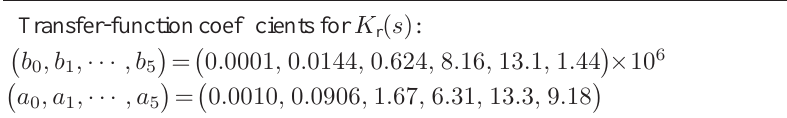
Table 1. Parameter values for the Wavestar C5 absorber. Parameter Symbol Value Unit Inertia of arm and float (with ballast water) J mech Hydrostatic restoring torque coefficient